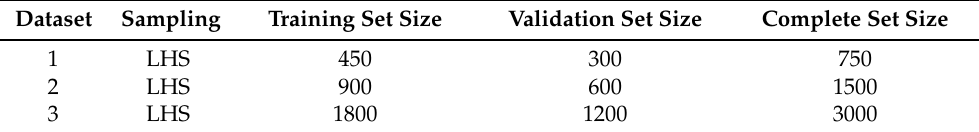
Table 2. Datasets for the training and validation of the investigations using the NN-based method.